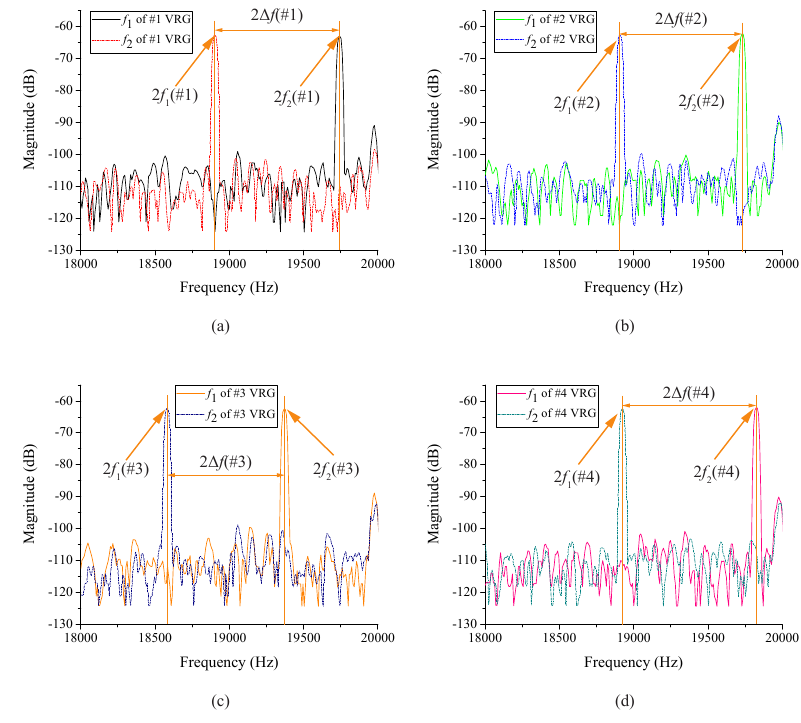
Figure 8. Second harmonic frequency data of four (100) VRG samples: ( a ) #1 VRG, ( b ) #2 VRG, ( c ) #3 VRG, ( d ) #4